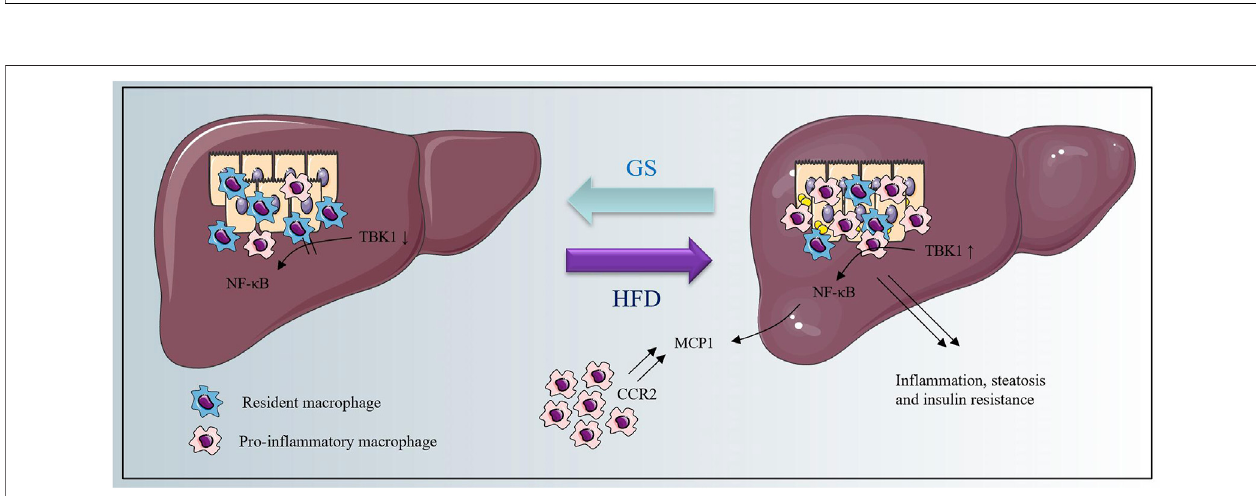
FIGURE 7 | The schematic